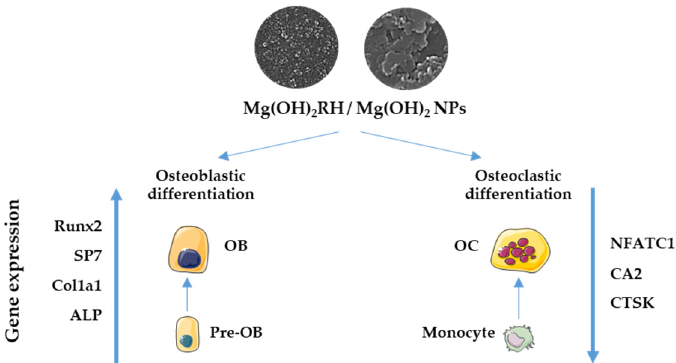
Figure 6. Schematic summary of the effect of Mg(OH) 2 and Mg(OH) 2 RH NPs in gene expression of osteoblastic (OB) and osteoclastic (OC) cells. Mg(OH) 2 RH NPs increased osteoblastic differentiation by promoting the expression of Runx2, SP7, Col1a1, and ALP, and reduced osteoclastic differentiation by downregulating the expression of NFATC1, CA2, and CTSK. In the present study, Mg(OH) 2 NPs functionalized with the RH extract were tested in similar levels and exposure conditions in osteoblastic and osteoclastic cells—a methodological advantage that is not shared by most studies that only address one of the cell types. Mg(OH) 2 RH NPs exhibited higher osteoblastic differentiation potential, as evidenced by the increased ALP activity and expression of relevant genes. Furthermore, these NPs also reduced the expression of some osteoclastogenic genes. These observations suggest the potential usefulness of Mg(OH) 2 RH NPs in bone regeneration.